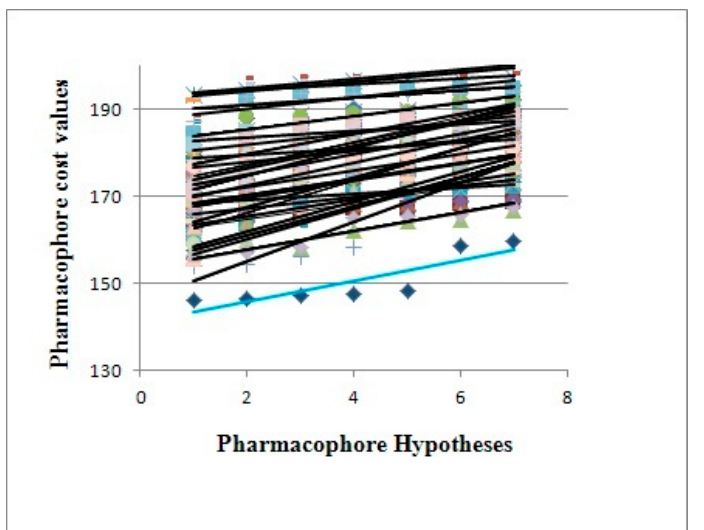
Figure 3. The cost difference between Hypo-1 (sky-blue color) and the scrambled runs (other